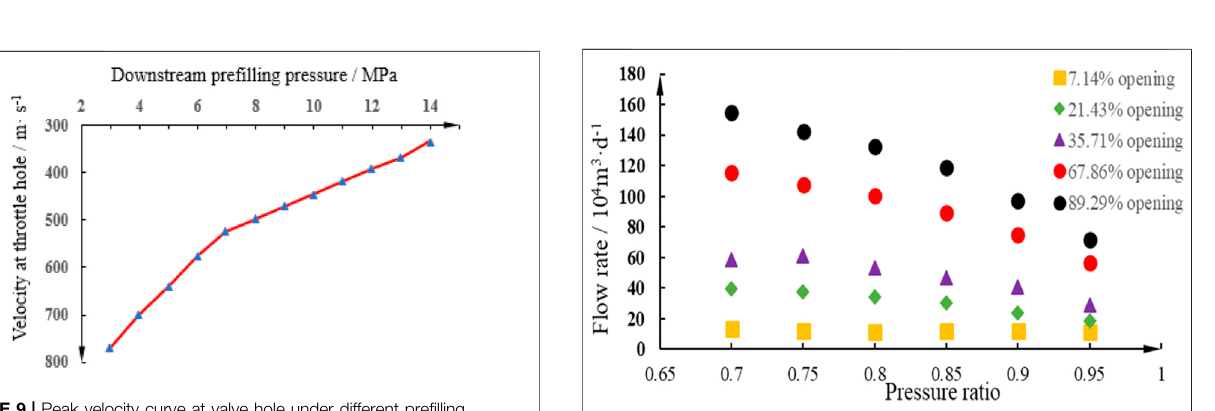
Frontiers in Earth Science |